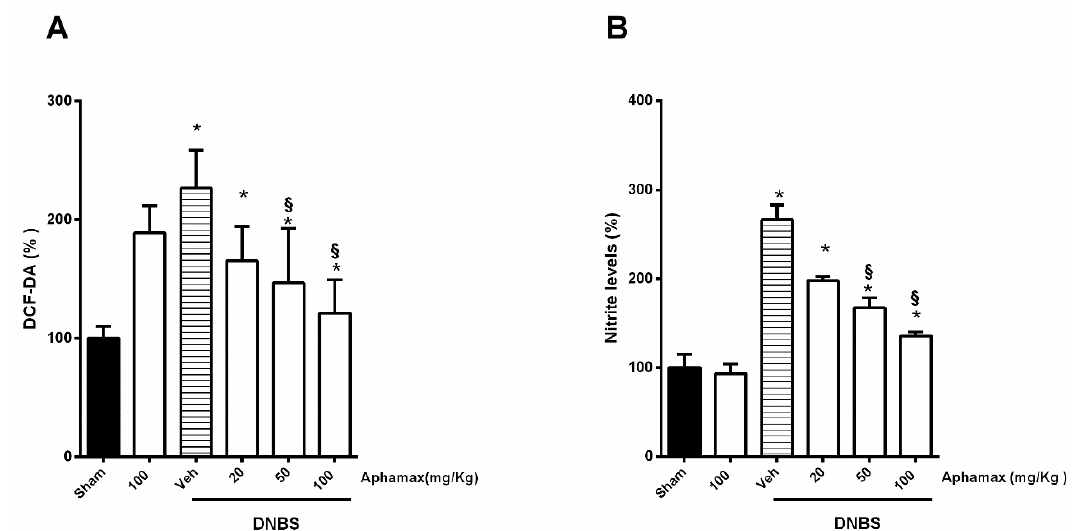
Figure 4. Effects of Aphamax ® on ROS and nitrite levels. ( A ) ROS levels measured using DCFH-DA, a peroxide/redox-sensitive fluorescent method. ( B ) nitrite levels detected using Griess assay. Data are means ± S.E.M. n = 5 for each group. * p ˂ 0.05 versus Sham group; § p ˂ 0.05 versus 2,4 dinitrobenzensulfonic acid (DNBS) group.